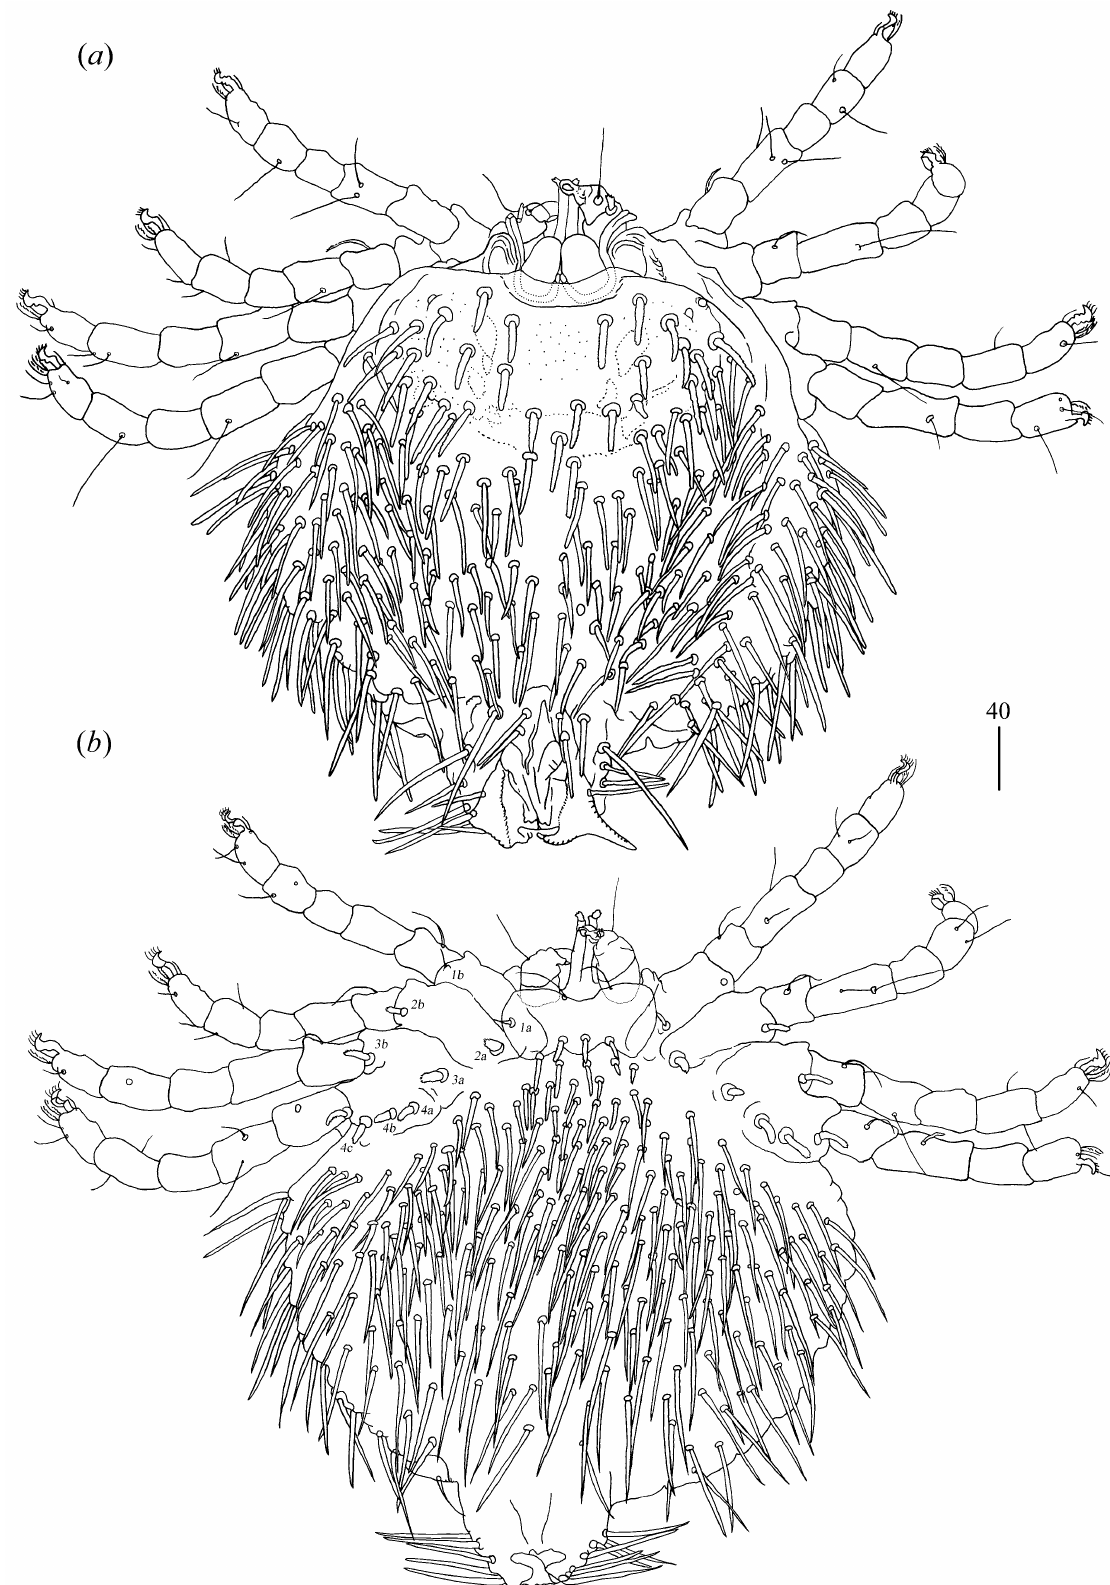
Figure 13. Geckobia unica sp. n. female: ( a ) in dorsal view; ( b ) in ventral view. Female (holotype). Gnathosoma . Chelicerae 80 long. Swollen, proximal part of chelic- eral base and slender distal part subequal in length, 40 long. Movable cheliceral digit three-pronged. Fixed cheliceral digit spinous, about 5 long. Palpal femur with filiform serrate setae dF and dG 40 and 55 long, respectively. Setae dF only slightly thicker than setae dG . Palpal tibia with three smooth setae ( dTi , l ′ Ti and l ″ Ti ) and curved claw. Palpal tarsi with four smooth setae. Subcapitular seta n filiform and serrate, about 35 long. Each branch of peritremes with barely visible chambers about 75 long. Hypostome with orna- mented apex. Idiosoma 340 long and 335 wide. Dorsum. Propodonotal shield well outlined,